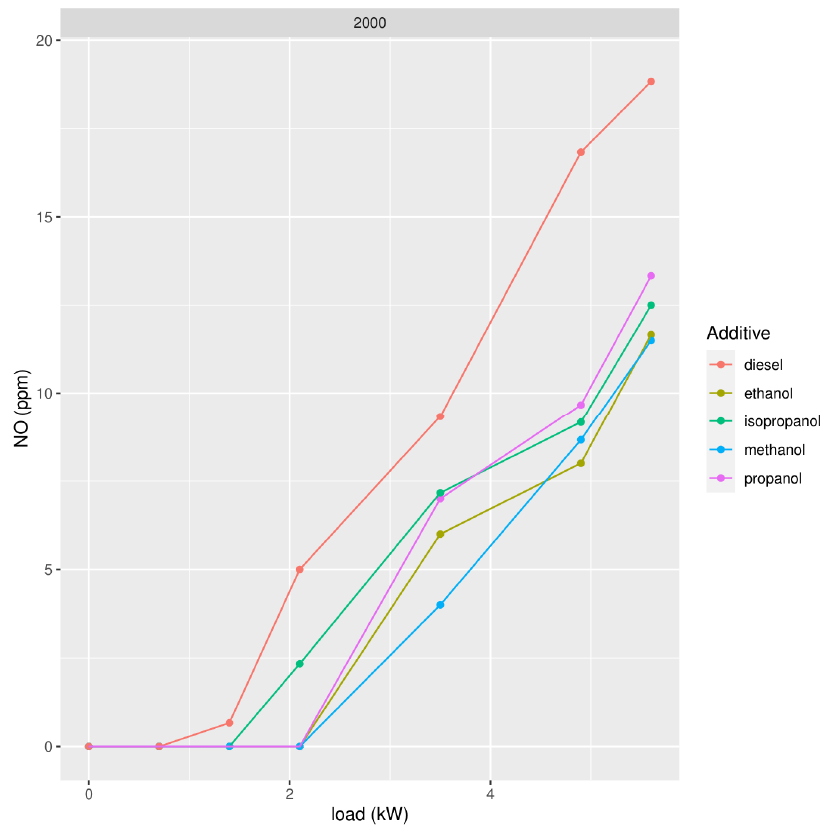
Figure 5. Concentration of NO in exhaust gases in function of the power of the diesel generator after addition of 2000 ppm of methanol, ethanol, propanol, and isopropanol.